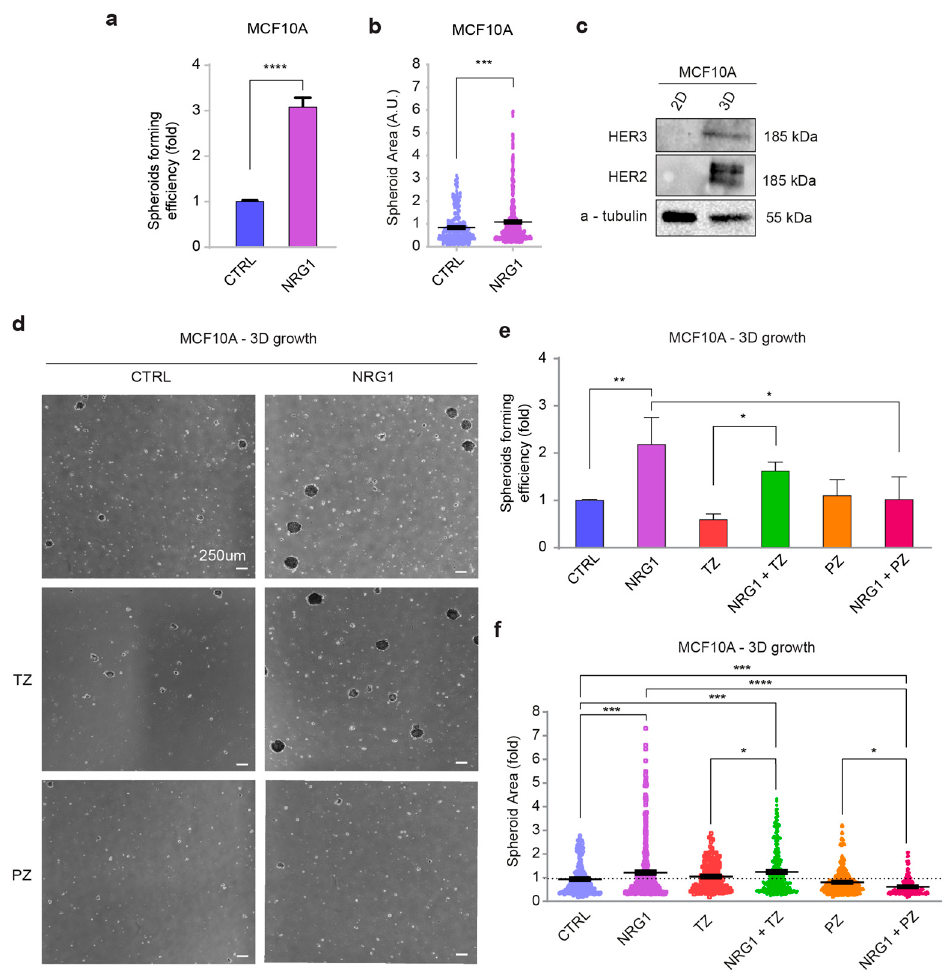
Figure 5. Administration of NRG1 β promotes the anchorage-independent growth of basal-like/triple-negative breast cells. ( a , b ) Spheroid forming efficiency and growth (size) of MCF10A cells upon stimulation with NRG1 β . MCF10A cells were seeded in ultra-low attachment plates and stimulated with/without NRG1 β (10 ng/mL) every 3 days for up to 14 days. Spheroid number (spheroid forming efficiency) and size are provided in ( a , b ), respectively. ( c ) Western blot analysis of ERBB3 and ERBB2 protein levels in lysates of MCF10A cells cultured in monolayer (2D) and non-adherent conditions (3D). ( d – f ) 3D cell growth of MCF10A cells upon stimulation with NRG1 β and simultaneous inhibition of ERBB2 by trastuzumab (TZ) or pertuzumab (PZ). MCF10A cells were seeded in ultra-low attachment plates and stimulated with/without NRG1 β (10 ng/mL), alone or in combination with trastuzumab (10 µg/mL) or pertuzumab (10 µg/mL). Stimulations were repeated every 3 days up to 14 days. Representative pictures are provided in ( d ). Spheroid number (spheroid forming efficiency) and size (spheroid growth) are provided in ( e , f ), respectively. In all panels, numerical data are normalized to control cells and presented as the mean (error bars show s.e.m.); statistical significance was determined using Student’s t -test in ( a , b ), and one-way ANOVA followed by Tukey’s test in ( e , f ); * p < 0.05, ** p < 0.01, *** p < 0.001, and **** p < 0.0001.